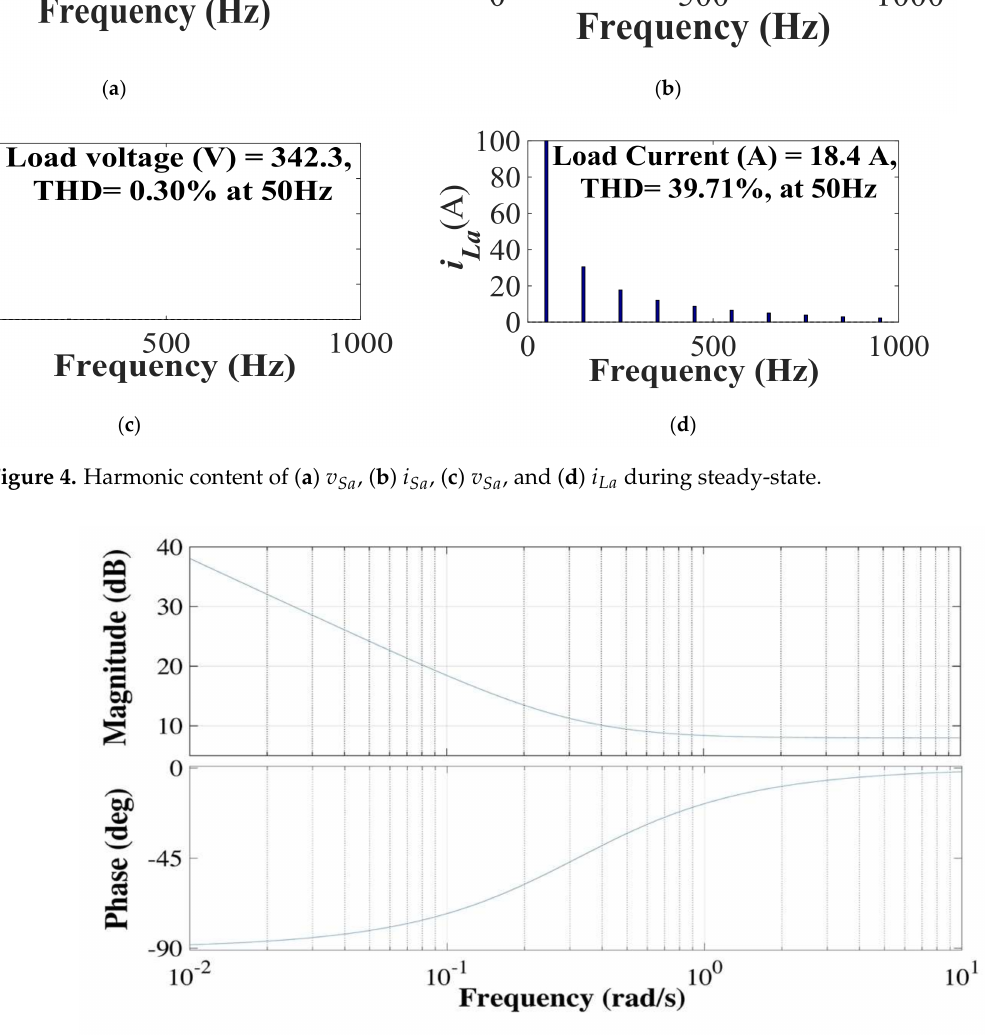
Figure 5. Bode plot analysis of DC bus during